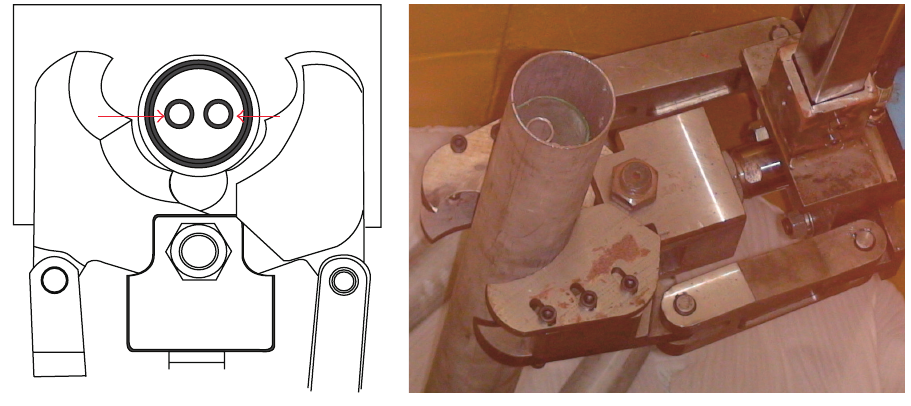
Figure 5: Series cutting.